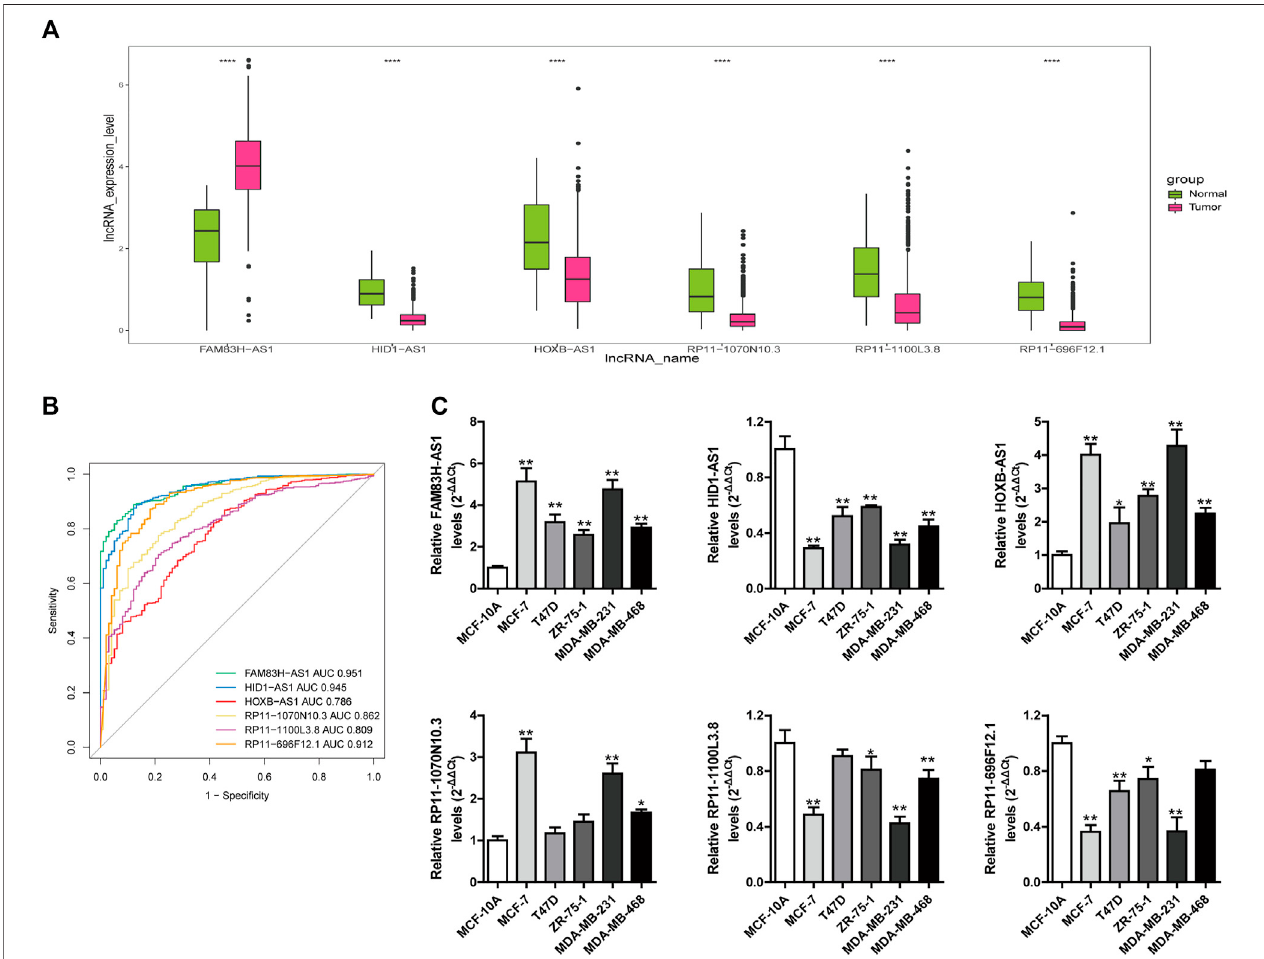
FIGURE 7 | Investigation of diagnostic value of lncRNAs in stemness-index-related lncRNA signature. Expression levels of these lncRNAs in stemness-index- relatedlncRNAsignatureinTCGAdatabase (A) ,andROCcurvestoevaluatetheircapabilityindistinguishingBCandnormalsamplesinTCGAdatabase (B) .Validationof expressionoflncRNAsinstemness-index-relatedlncRNAsignaturebyquantitativereal-timepolymerasechainreaction (C). Resultswereshownasmean±SD.* p < .05 ** p < .01 vs . MCF-10A.